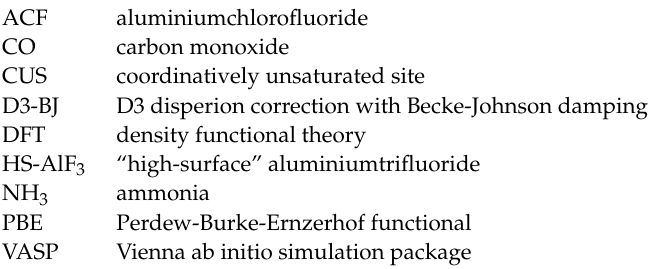
Table S1: Summary of NH 3 vibrations on different α -AlF 3 -surfaces and their Cl-substituted analogons, Table S2: Summary of atomic charges of adsorption sides at different α -AlF 3 -surfaces and their Cl- substituted analogons along with the adsorbed molecules, Table S3: Summary of atomic charges of adsorption sides at different α -AlF 3 -surfaces and their Cl-substituted analogons along with the adsorbed